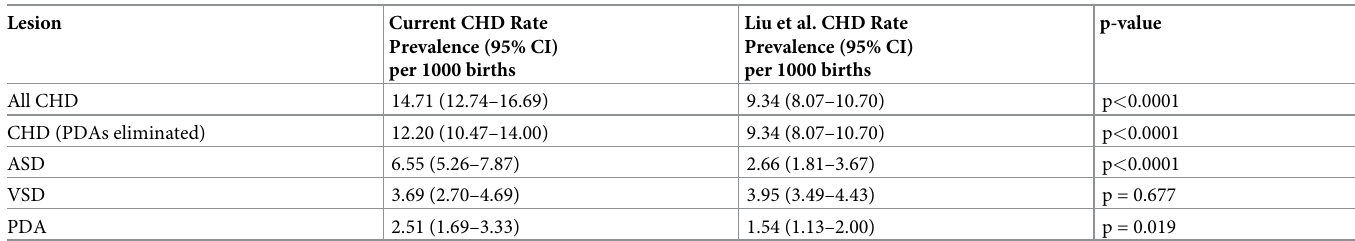
Table 2. Comparison of current Da Nang region / Asian CHD Sub-type birth prevalence.